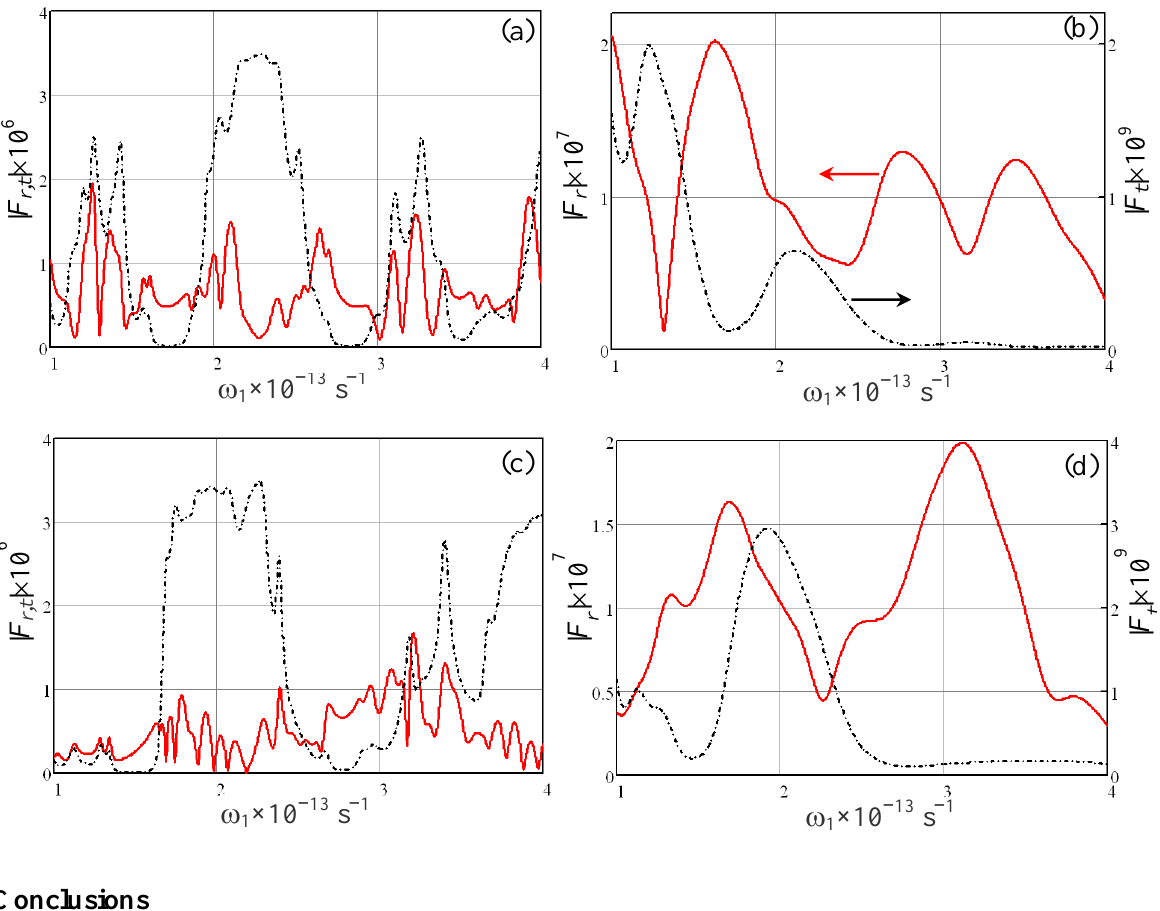
= ω + ω from ( a , b ) Fibonacci S and 3 1 2 8 |-solid red lines) and forward (| F |-dash-dot r t = 2.01 × 10 13 s −1 . The layer parameters are the 2 = 0.01 and ( b , d ) - tanδ = 0.1. The xx , zz xx , zz = 30° and Θ = i 1 i 2